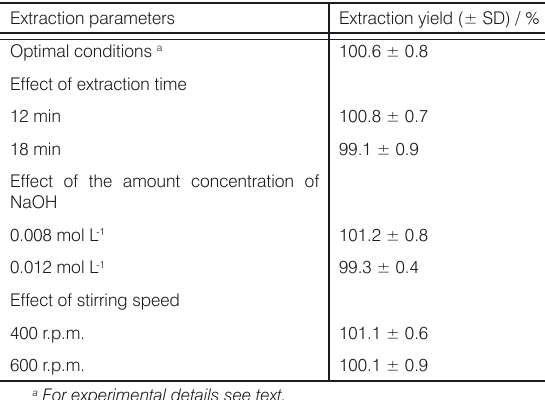
a For experimental details see text.